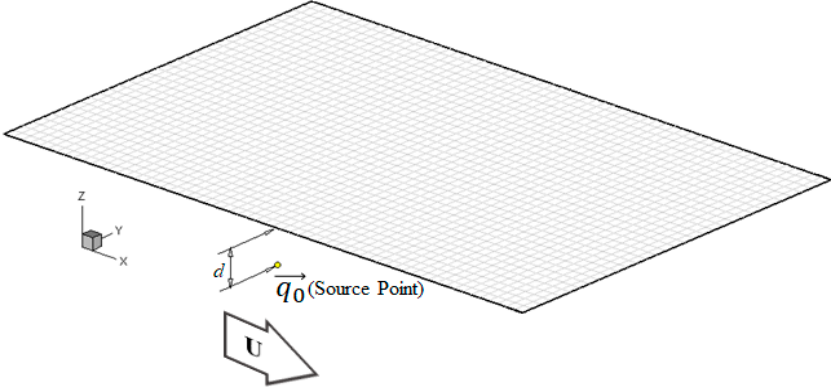
Figure 7. Computation configuration for the moving source point under water.